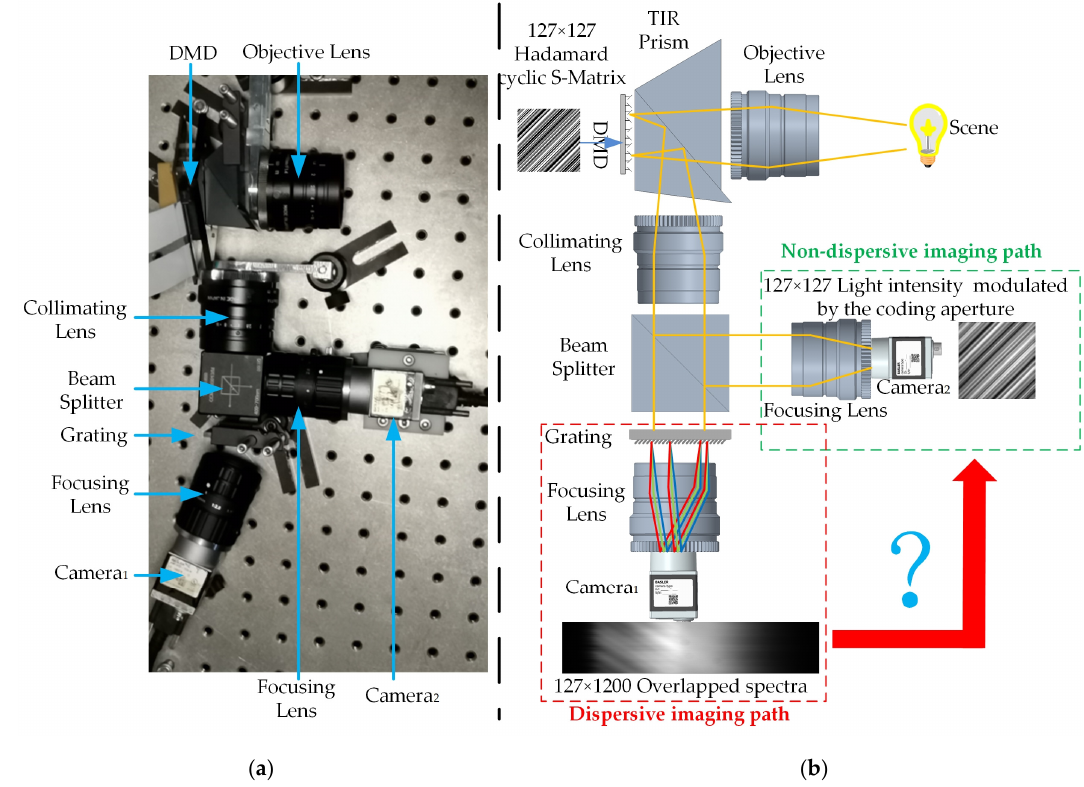
Figure 1. The flowchart of dual-path snapshot Hadamard transform spectrometer (HTS). ( a ) Actual system diagram of HTS. ( b ) Principle system diagram of HTS.